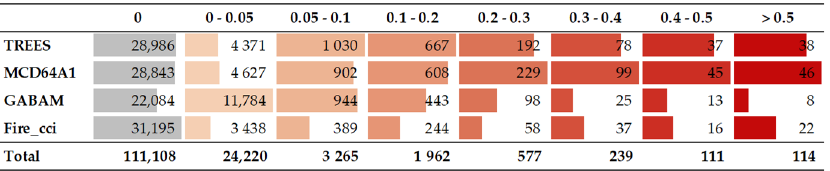
Figure 6. Number of cells in different burned proportion classes.